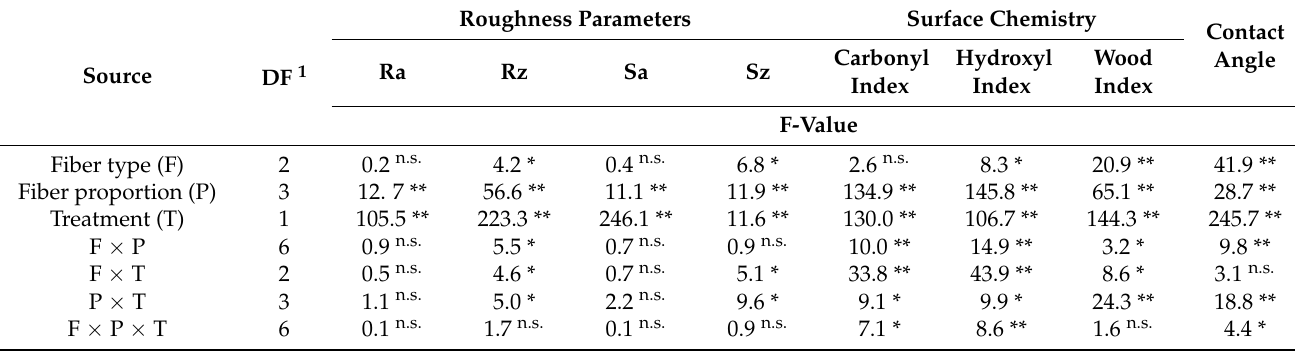
Table 2. Analysis of variance, with F-values for the studied factors (fiber type, fiber proportion, treatment, and their interactions), and their significance, for roughness parameters, surface chemistry, and composites contact angle. Roughness Parameters Surface Chemistry Ra Rz Sz Source DF 1